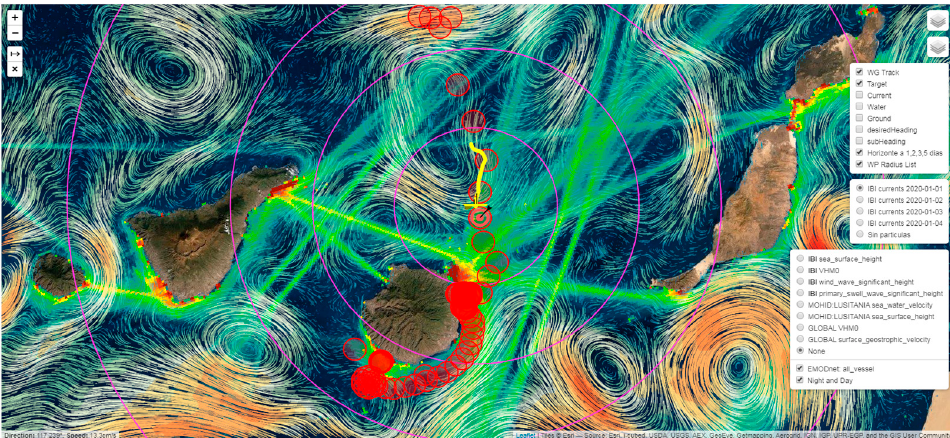
Figure 6. Platform guidance and navigation system. Table 1. Table with results derived from the four methods